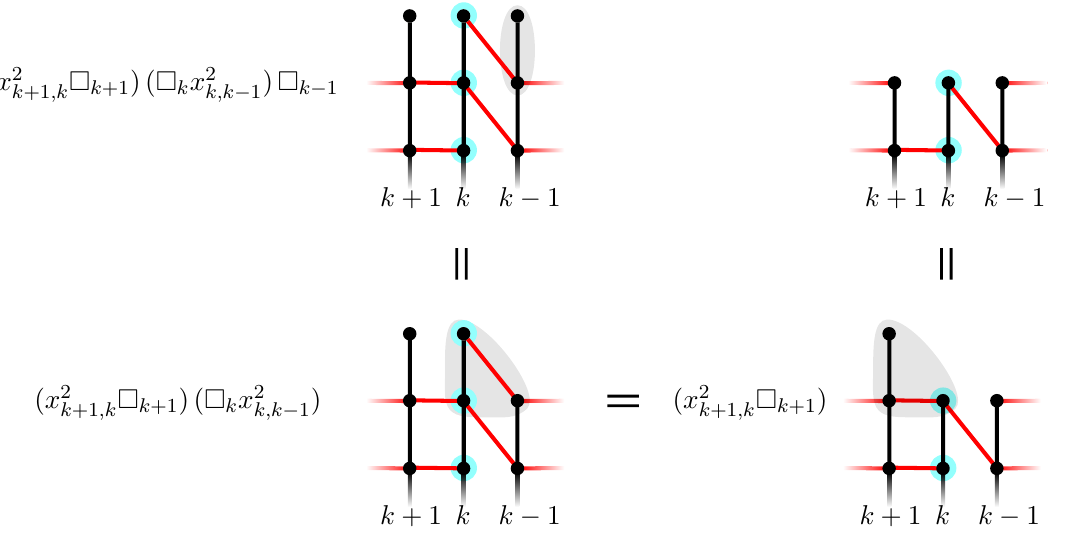
Figure 4 . In the presence of a magnons, the inverse of the graph building operator is more involved. Here, we demonstrate how the operator is inverted for the case where there is a magnon at the k ’th site but no magnons at the neighboring